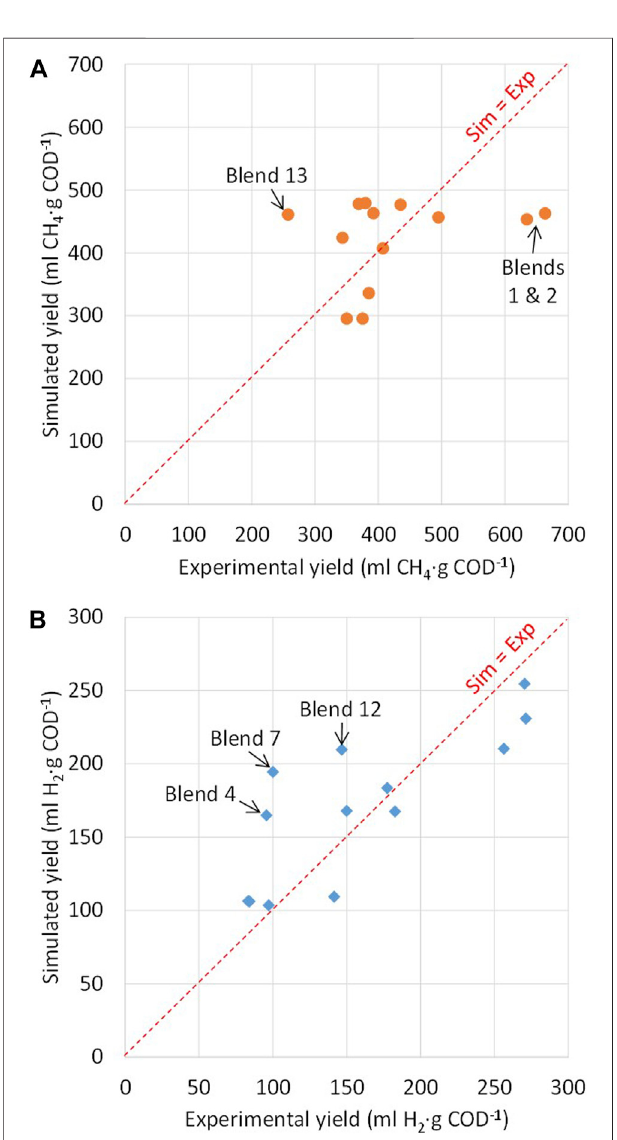
FIGURE 2 | Simulated and experimental biogas production yields: (A) anaerobic digestion (AD); (B) dark fermentation